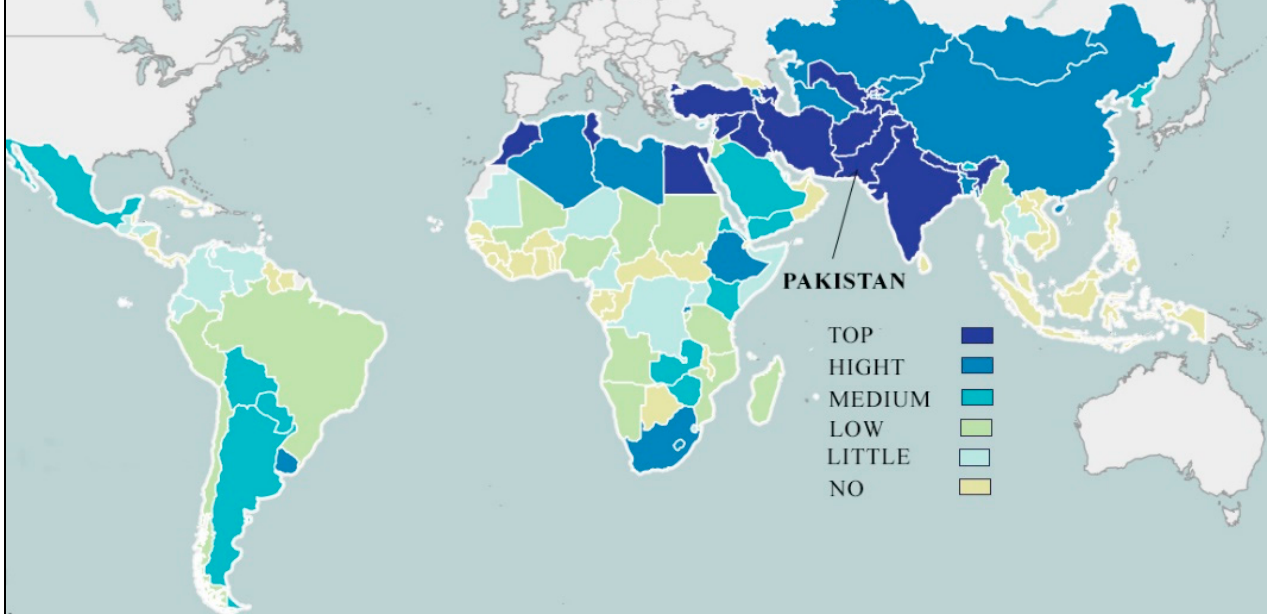
Figure 2. Zinc-wheat priority level (source harvest plus): available at https://bpi.harvestplus.org/bpi_cropmaps.html?id=c8 (accessed on 28 March 2022).